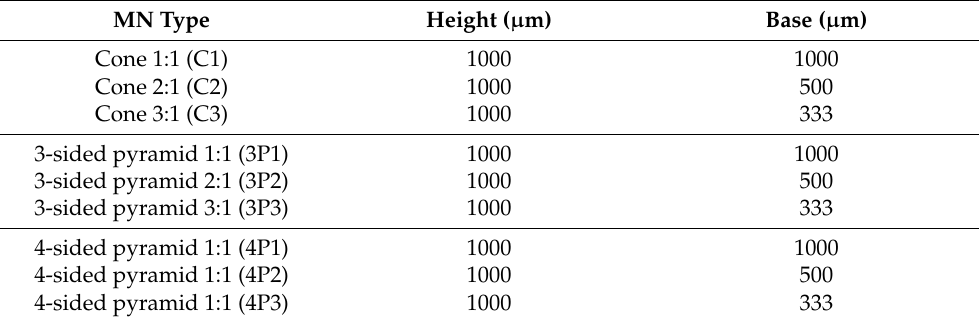
Table 1. MN dimensions from CAD